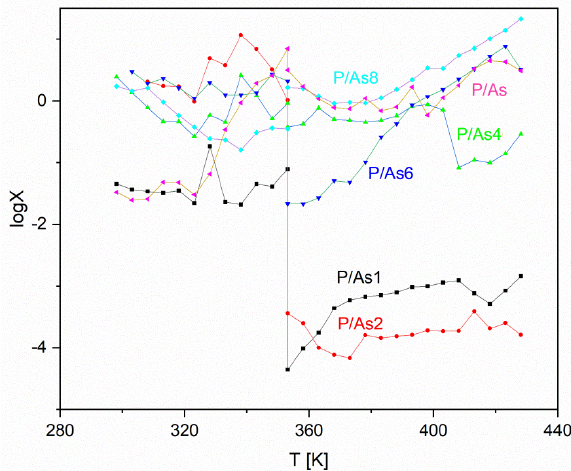
Figure 8. Values of the X estimator (see Equation 1 for the exact definition) are depicted as a func- tion of temperature for all relevant pairs of the materials investigated. Composite samples: As1 (90% Gm + 10% HUAs); As2 (80% Gm + 20% HUAs); As6 (40% Gm + 60% HUAs); As8 (18% Gm + 82% HUAs) (values in